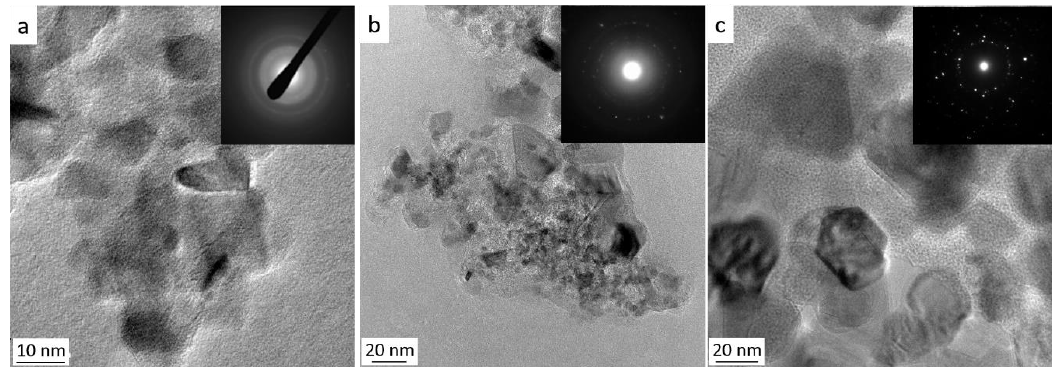
Figure 15. TEM micrographs of P-1500NH ( a ), P-1500N ( b ) and P-1500A ( c ) samples with selected area electron diffraction pattern as insets.